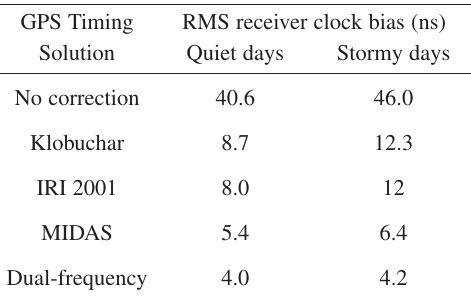
Table I. RMS midday (12:00 UT) receiver clock bias (ns) referenced to the receiver clock bias from CODE (using the fixed receiver solution) for the qui- et and stormy days selected from each month of 2002 at VILL, excluding September due to data